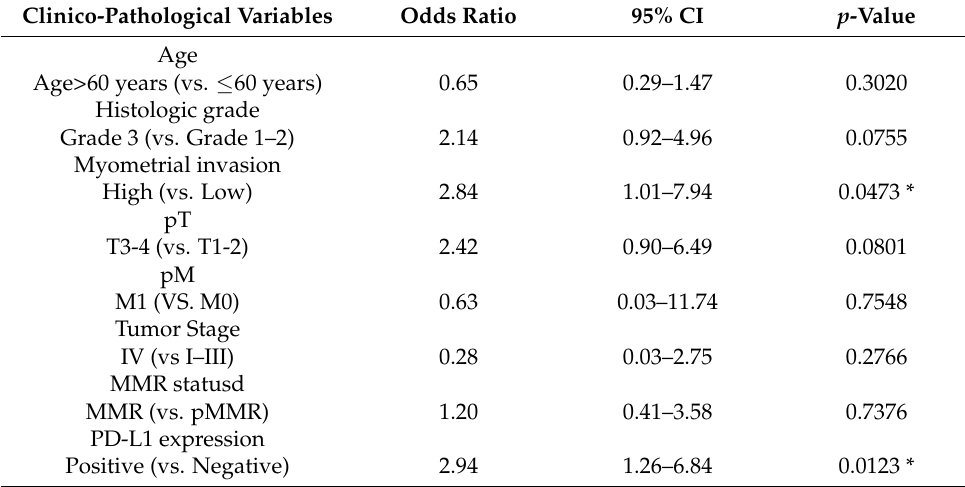
Figure 2. Survival Analysis of PD-L1 protein expression. Kaplan–Meier survival plot showing no statistically significant difference between PD-L1 positive and negative tumors for ( A ) overall survival, ( B ) recurrence-free survival and ( C ) disease-free survival. Table 3. Multivariate analysis to assess relationship between lymph node metastasis and clinico- pathological characteristics.